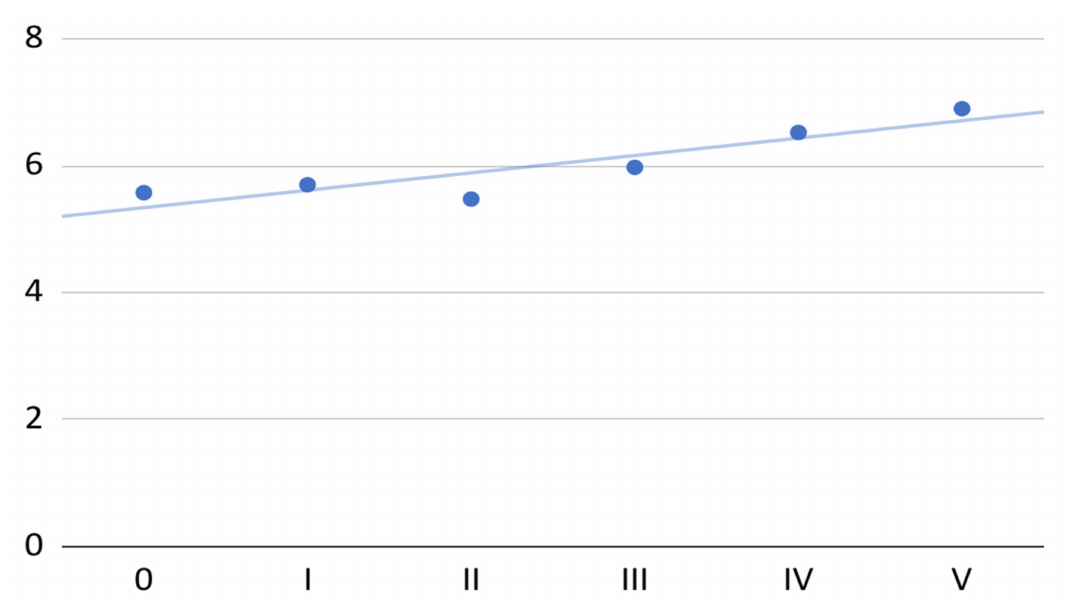
Figure 2. Mean mastication efficiency on the VAS at individual